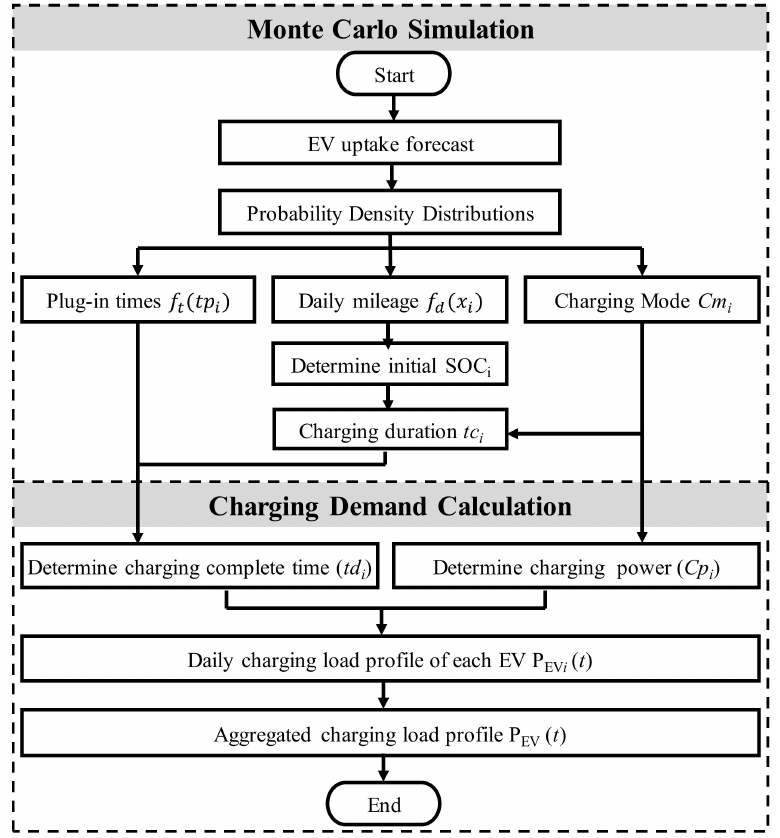
Figure 3. Monte Carlo simulation and EV charging demand